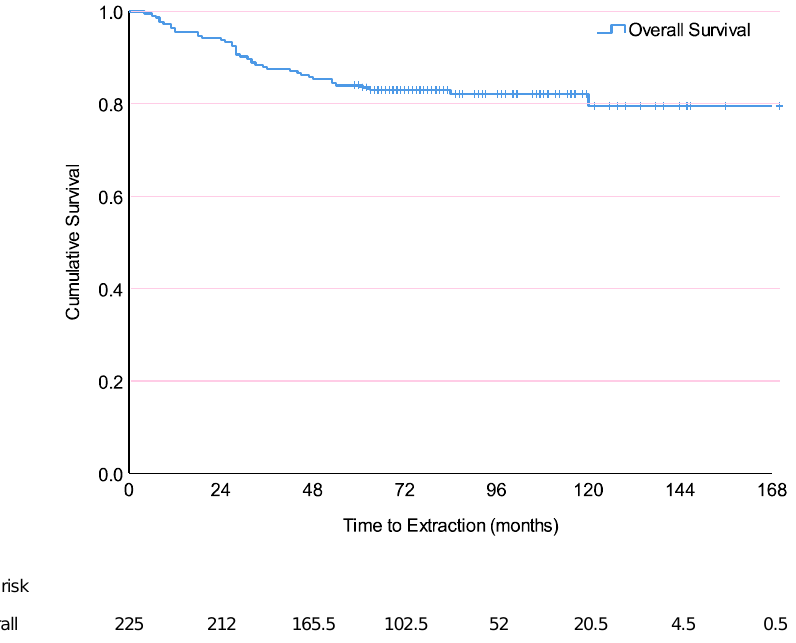
Figure 2. Kaplan–Meier survival analysis of endodontic microsurgery teeth ( n = Figure 2. Kaplan – Meier survival analysis of endodontic microsurgery teeth ( n = 225).